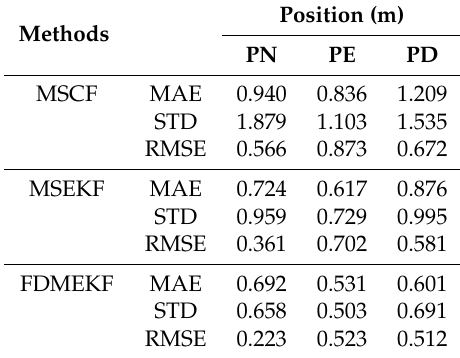
Table 3. MAE, STD, and RMSE of the position achieved by MSCF, MSEKF, and FDMEKF for the experimental